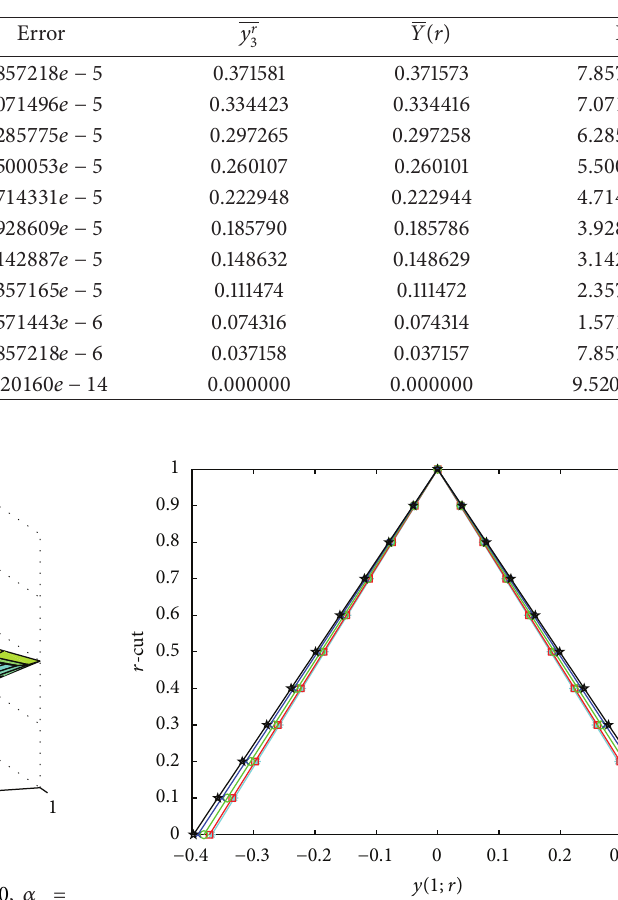
Table 4: The result of the proposed method for Example 60 with 𝛼 = 0.95 and 𝑚 = 3 .